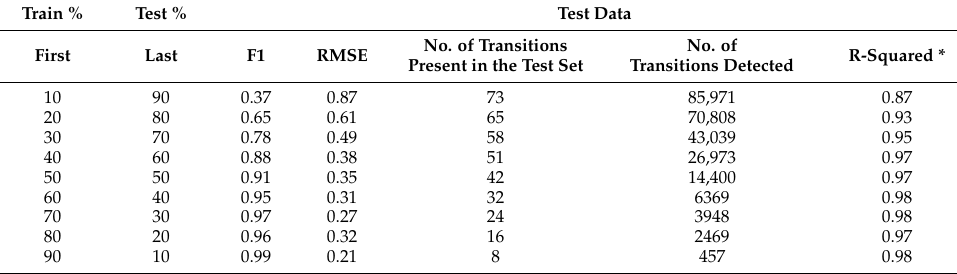
Table 10. Forecasting efficacy of the CNN model for different training and testing